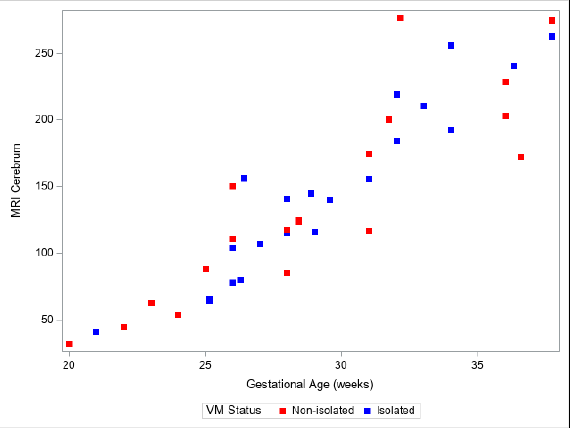
Figure 4. Three-dimensional growth trajectory measurements of supratentorial fetal brain volume in isolated and non-isolated VM.